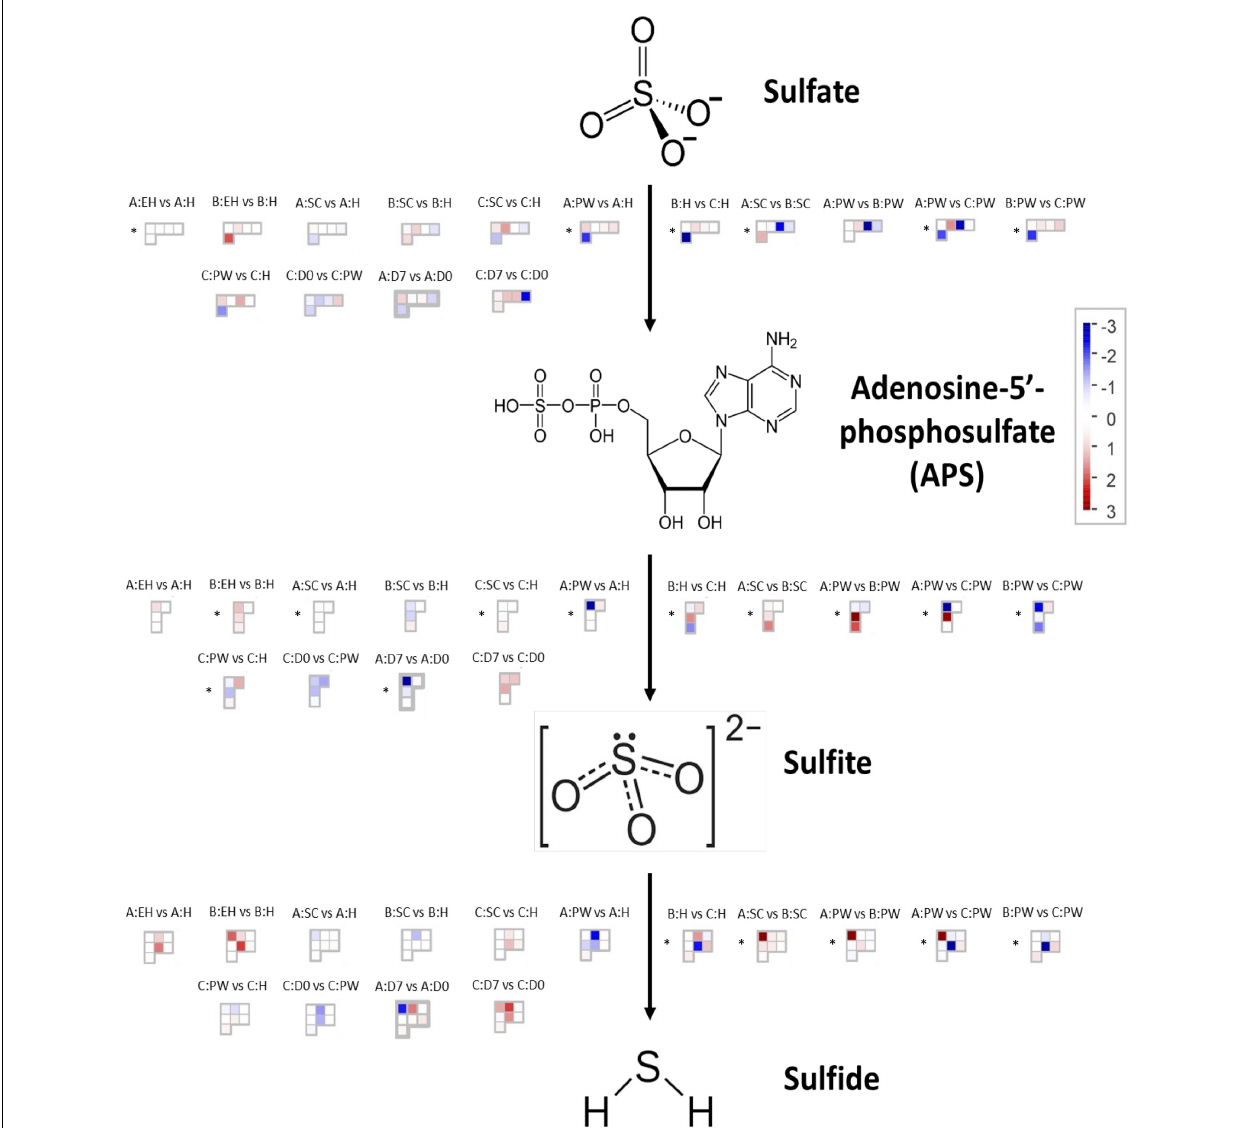
FIGURE 5 | RNAseq expression data (FPKM) for genes involved with sulfate assimilation in three elite inbred lines of Eruca sativa . A custom MapMan (version 3.6.0RC1) annotation file of the E. sativa reference genome was created using Mercartor4 (version 1.0, plaBi dataBase, Institute of Biology, Aachen, Germany), and used to visualize differential expression of genes within the sulfate assimilation pathway. Asterisks denote significance of up/down regulation. EH , early harvest; H , harvest; SC , second harvest; PW , pre-wash; D0 , post-wash; and D7 , 7-day shelf